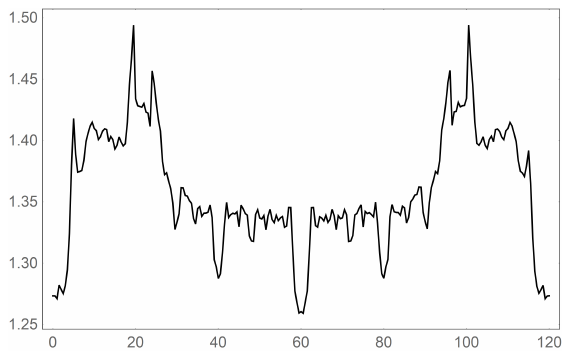
( 3 ) h ( e i θ z ) versus phase rotation 0 ◦ to 120 ◦ . This was calculated 30